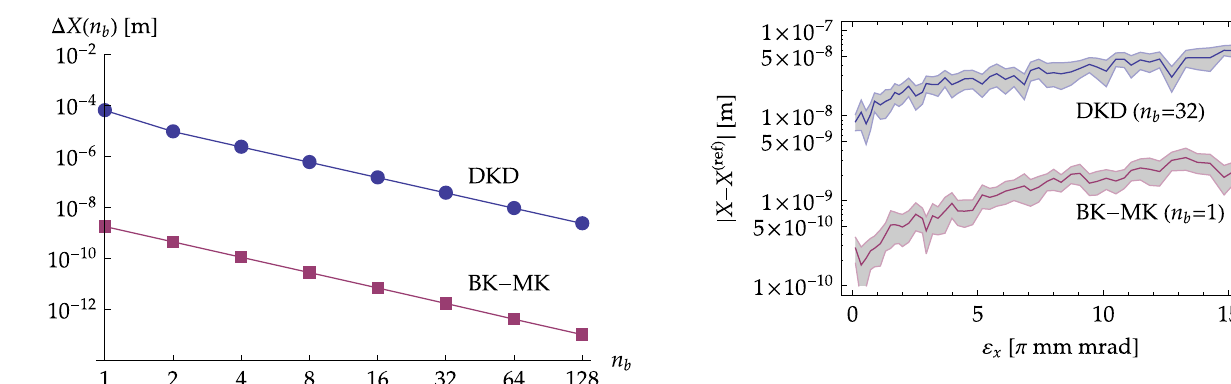
for drift-kick integration b 256 . b ¼